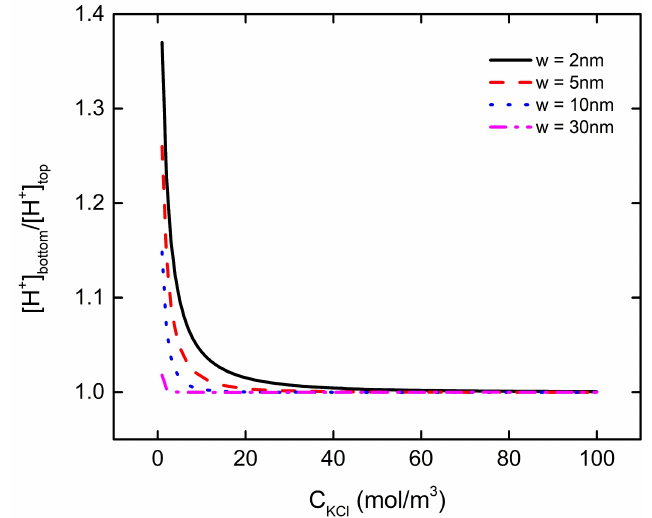
Figure 9. The ratio of the local concentration of H + at the bottom and the top of the particle as a function of C KCl under di ff erent distances between particle and plate at pH =